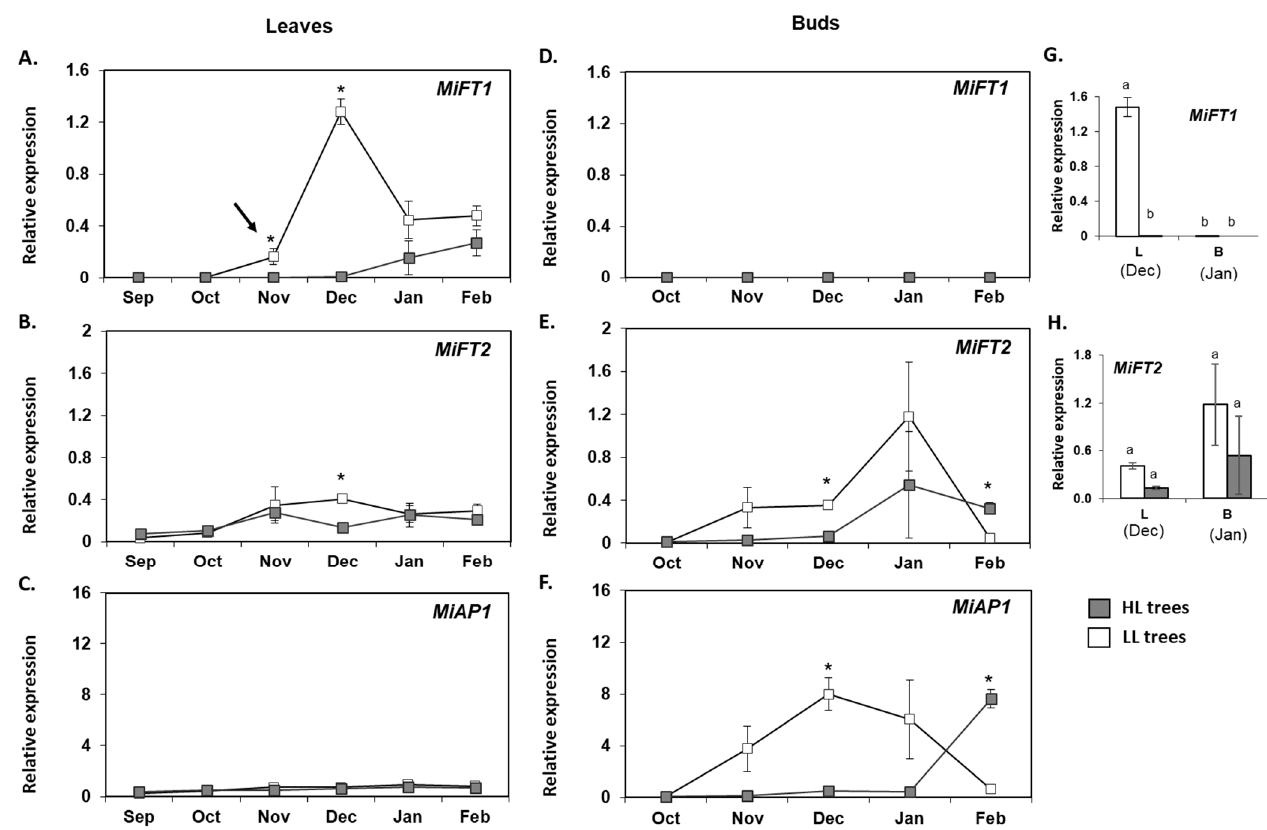
Figure 7. Seasonal expression profiles of MiFT1 , MiFT2 and MiAP1 in leaves ( A – C ), and buds ( D – F ) of HL (heavy load), and LL (light load) ‘Shelly’ trees. Tissue sampling was performed using six uniform HL and LL trees that were divided into three pairs of trees at the beginning of May 2017. The collected leaves and terminal buds were dissected and pooled to form three biological replicates (for each tissue and tree status). Data are means±SE of three independent replicates. Asterisks (*) denote a significant difference between the transcript expression in HL and LL tissues at the same time point, using least significant difference (LSD) test, according to pairwise comparison by Student’s t -test, with p ≤ 0.05. Sampling intervals are shown on the X -axis. The timing of flower induction is indicated by black arrow. Comparison of MiFT1 and MiFT2 expression in leaves (L) vs. buds (B), at those time points at which its expression was maximal ( G , H ). Different letters indicate significant differences according to Tukey–Kramer multiple comparison test, with p ≤ 0.05.